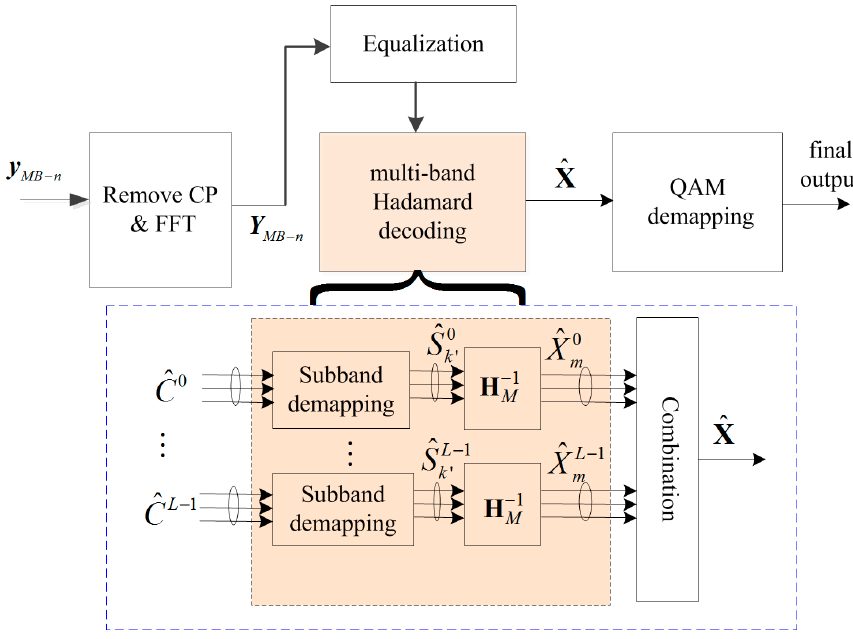
Figure 3. Diagram of proposed decoding at receiver.